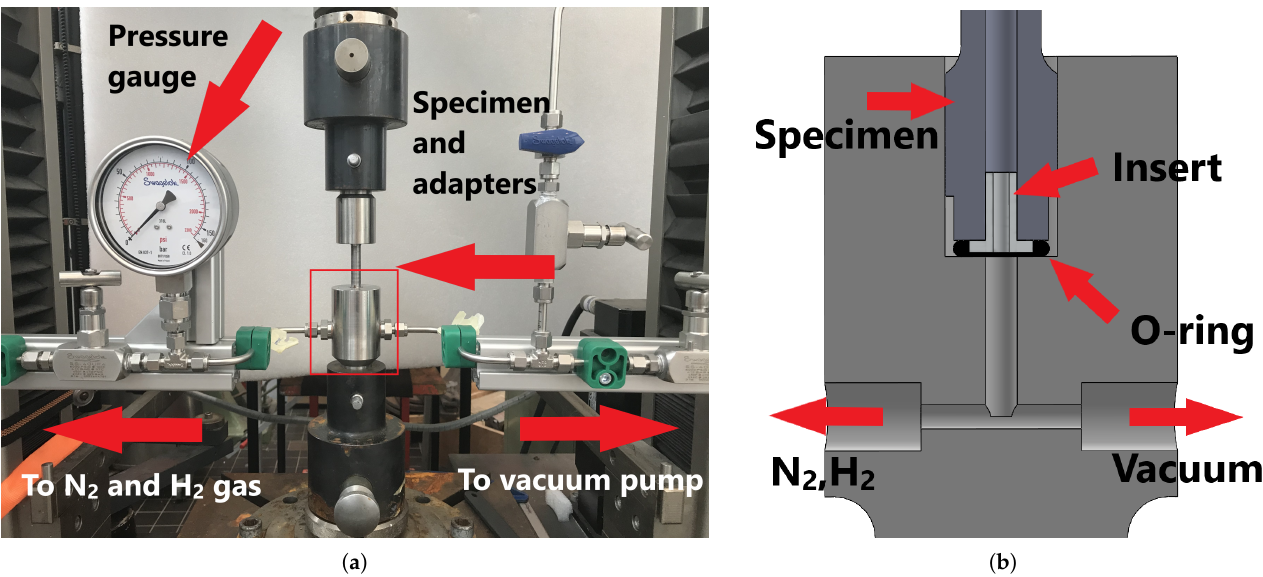
Figure 4. ( a ) Overview of the specimen and adapters inside the tensile tester. ( b ) Cross-section of the area outlined in red in ( a ) displaying the connection between the specimen and the bottom